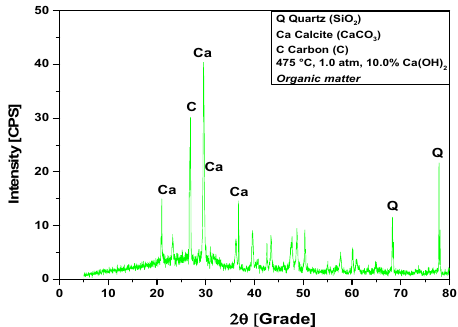
Figure 14. XRD of solid phase products by catalytic cracking of (organic matter + paper) fraction of MHSW at 475 °C, 1.0 atm, with 10.0% (wt.) Ca(OH) 2 , using a borosilicate glass reactor of 125 mL in laboratory scale.